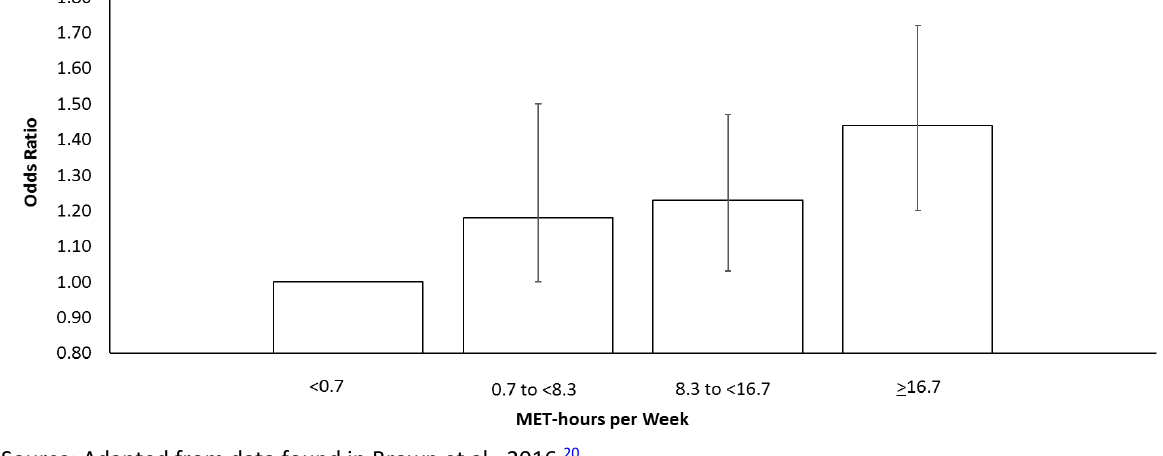
Figure F5-1. Odds of Maintaining a Healthy Weight by Level of Physical Activity